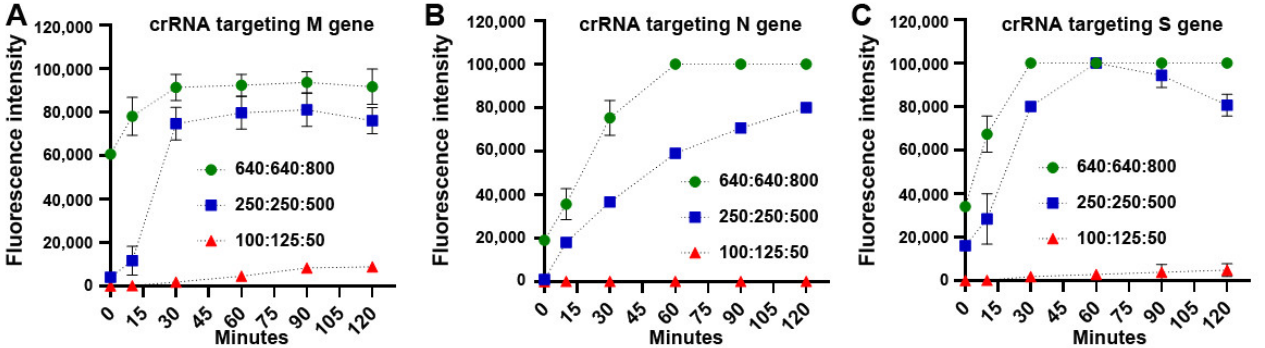
Figure 3. Time courses of fluorescence detection with different concentrations of LbaCas12a: crRNA: ssDNA-FQ reporter to target M ( A ), N ( B ), and S ( C ) of SARS-CoV-2, respectively. The condition of 640 nM LbaCas12a: 640 nM crRNA: 800 nM FAM quencher reporter had significantly increased fluorescence signals for quickly detecting the genes compared with the other conditions.